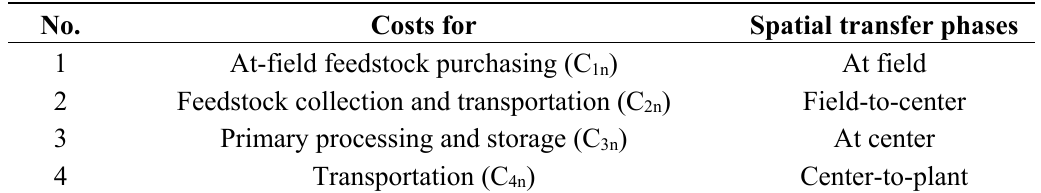
Table 2. Composition of feedstock